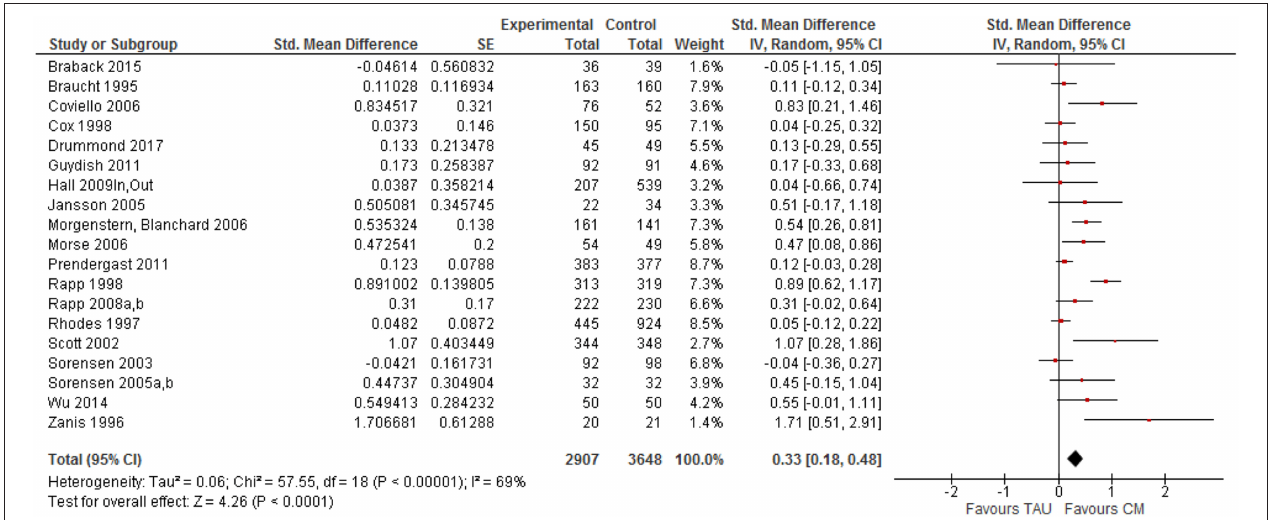
FIGURE 4 | Forest plot Case management vs. TAU: Treatment related